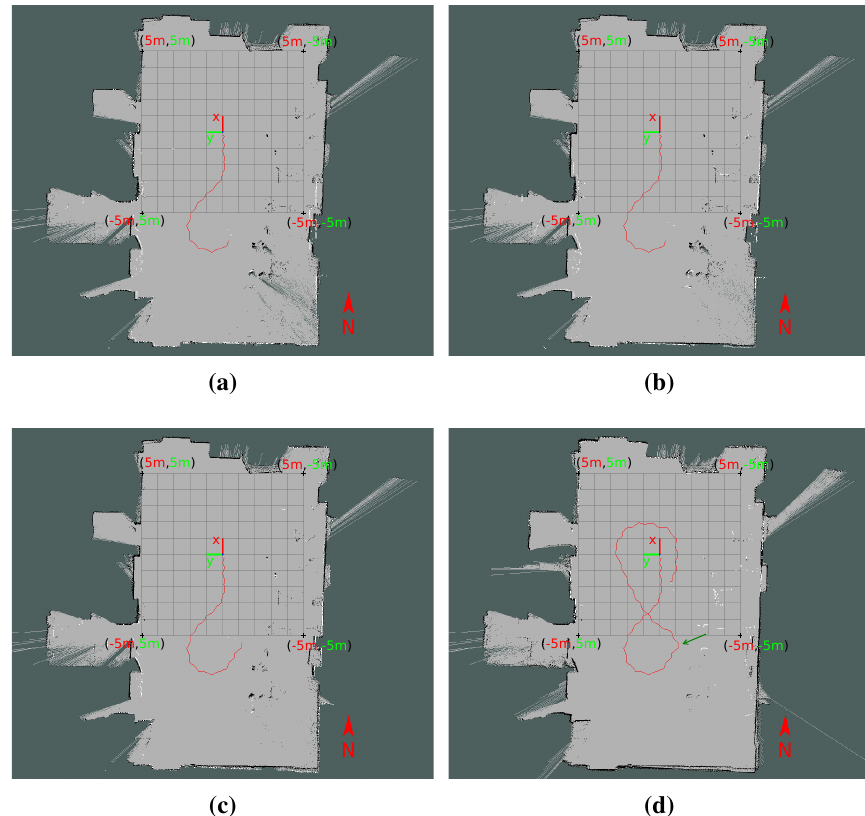
Figure 4. Four frames showing the 2D maps created by HectorSLAM for Experiment 1 in the local coordinate system after 41 seconds ( a ), 43 seconds ( b ), 45 seconds ( c ) and the final result after 93 seconds ( d ). The red lines denote the trajectory. The superimposed grid has a size of 10 × 10 m 2 . The green arrow denotes the part of the trajectory where the 2D registration lead to inaccuracies in the lower right corner between (b,c).